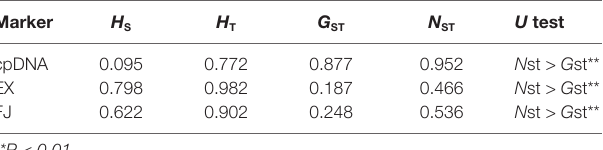
TABlE 2 | Genetic diversity and genetic differentiation of the combined chloroplast DNA (cpDNA) and single-copy nuclear DNA in all populations of the Cycas taiwaniana complex.